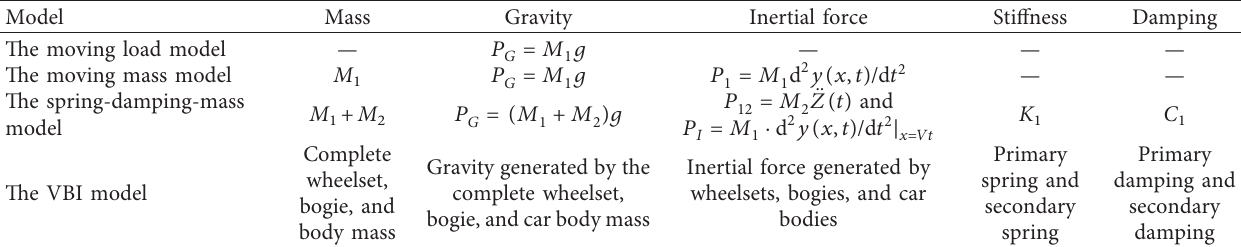
Table 1: Simplified comparison of different models.